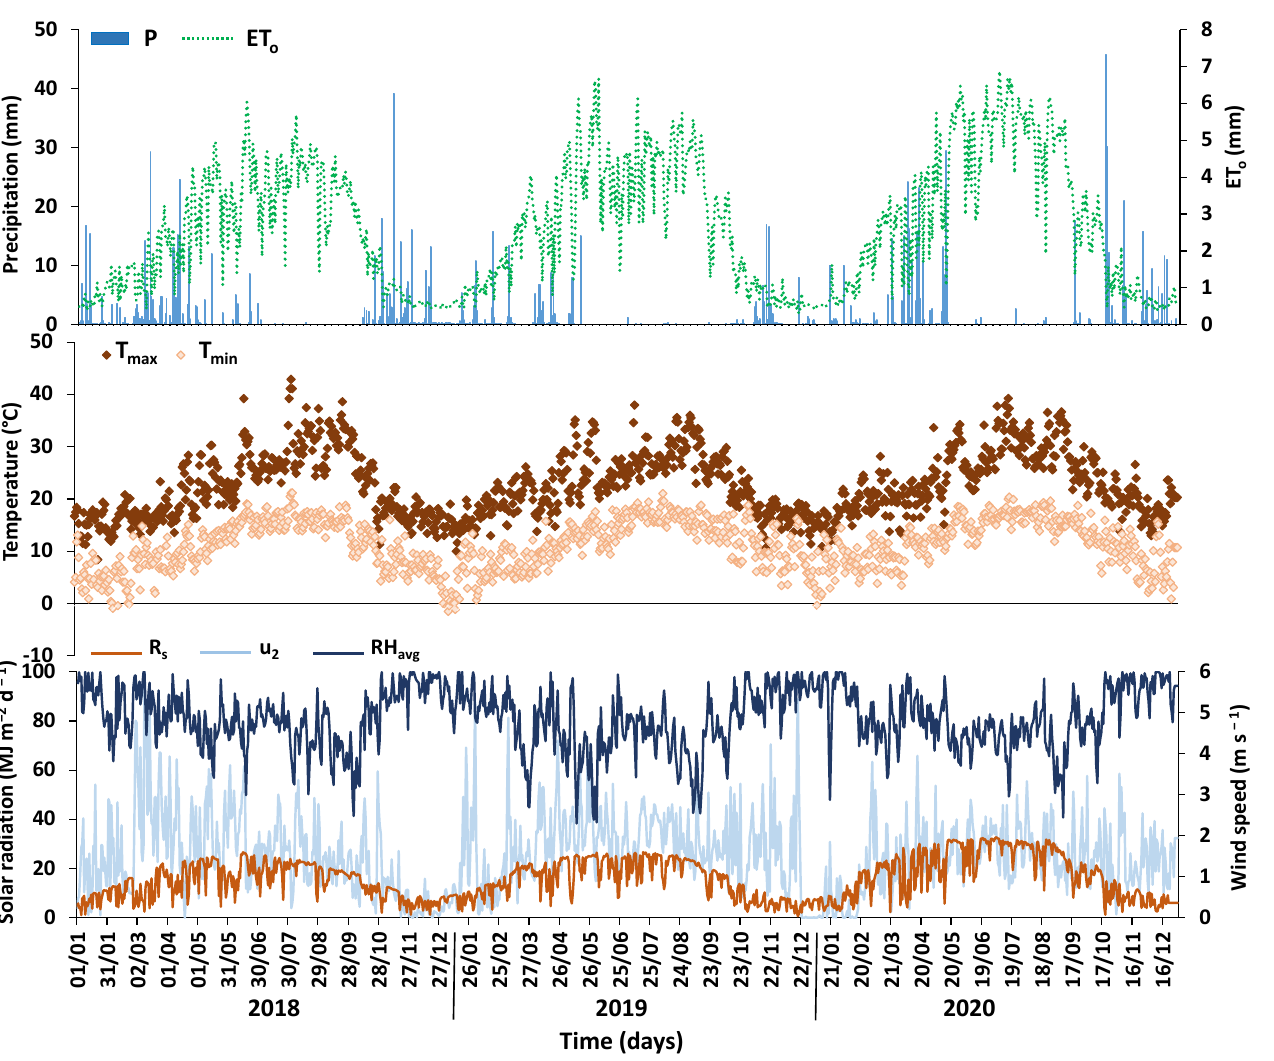
Figure 1. Weather data for the study period (P, precipitation, ET o , reference evapotranspiration; T max and T min , maximum and minimum surface air temperatures, respectively; RH avg , mean relative humidity; R s , solar radiation, u 2 , wind speed at 2 m height).